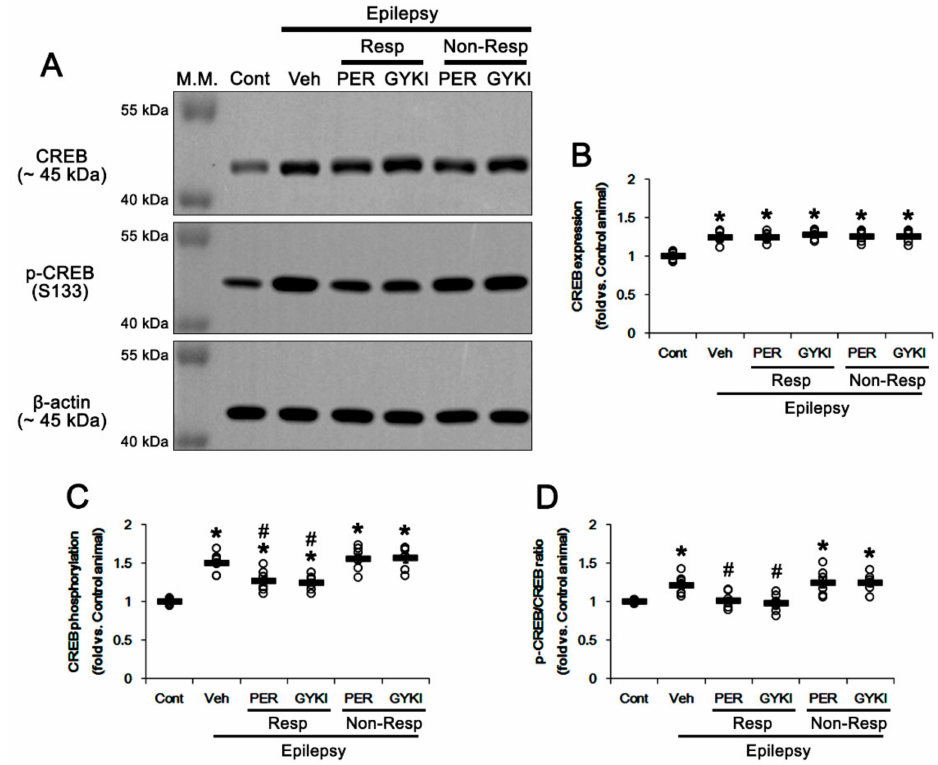
Figure 7. The effects of perampanel (PER) and GYKI 52466 (GYKI) on total Ca 2+ /cAMP response element-binding protein (CREB) expression and its S133 phosphorylation in chronic epilepsy rats. ( A ) Representative images for Western blot of CREB and its S133 phosphorylation level in the hippocampal tissues. ( B – D ) Quantifications of CREB (B), p-CREB S133 ( C ), and p-CREB/CREB ratio ( D ) in the hippocampal tissues. Open circles indicate each individual value. Horizontal bars indicate mean value. Error bars indicate SEM ( * ,# p < 0.05 vs. control (Cont) and vehicle (Veh)-treated animals, respectively; one-way ANOVA with post hoc Bonferroni’s multiple